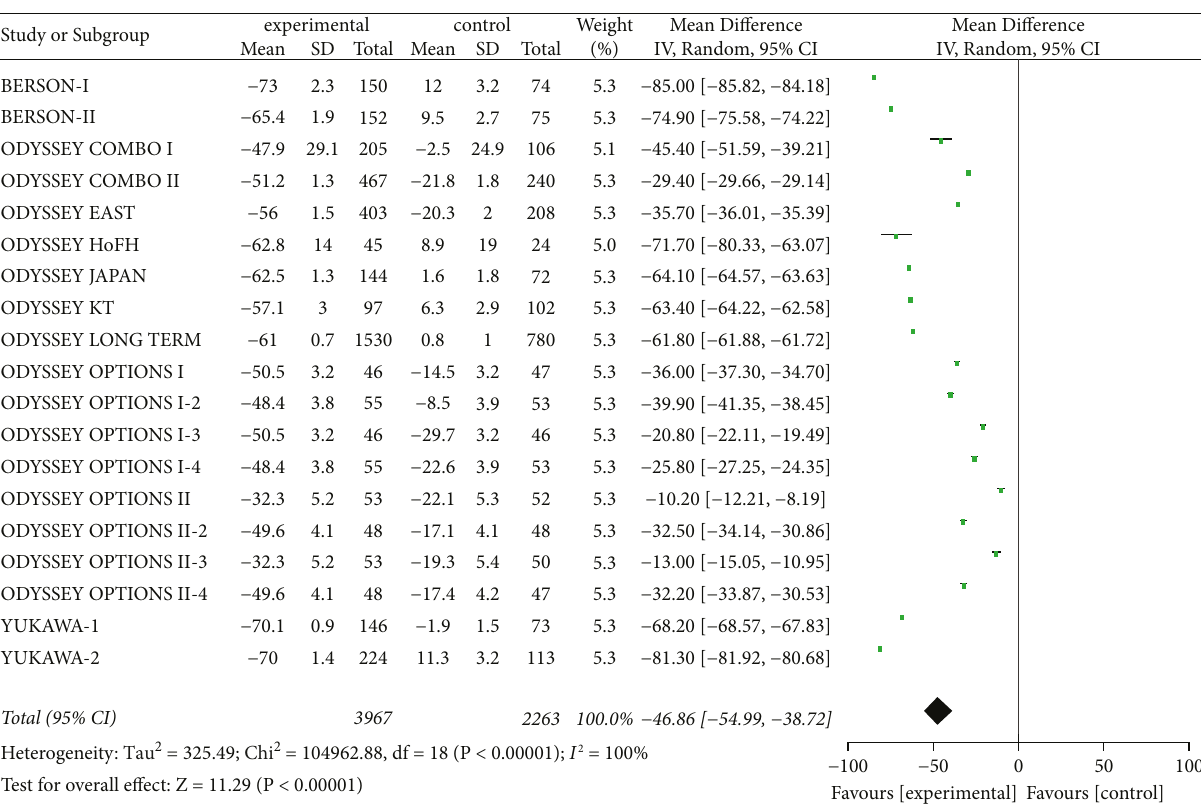
Figure 4: Comparison of the reduction of serum LDL-C (%) from baseline between control group and experimental group.